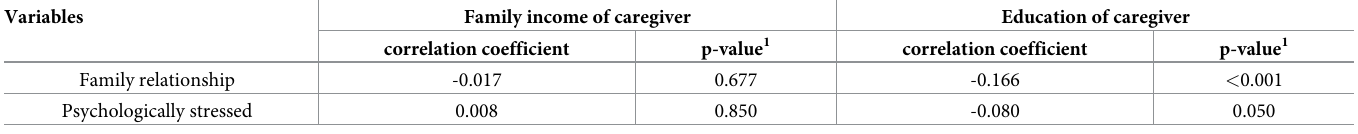
Table 4. The socioeconomic conditions and occupation of caregiver’s impact on stress level and family